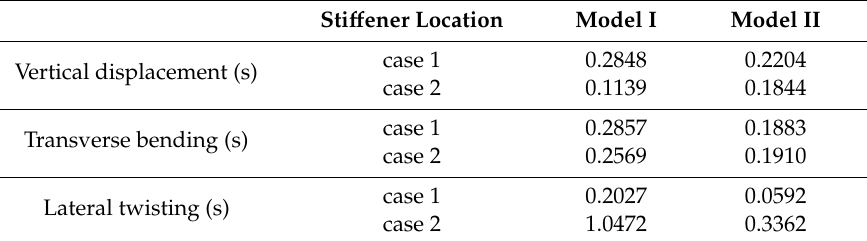
Table 4. Settling time of two models for LQR control.